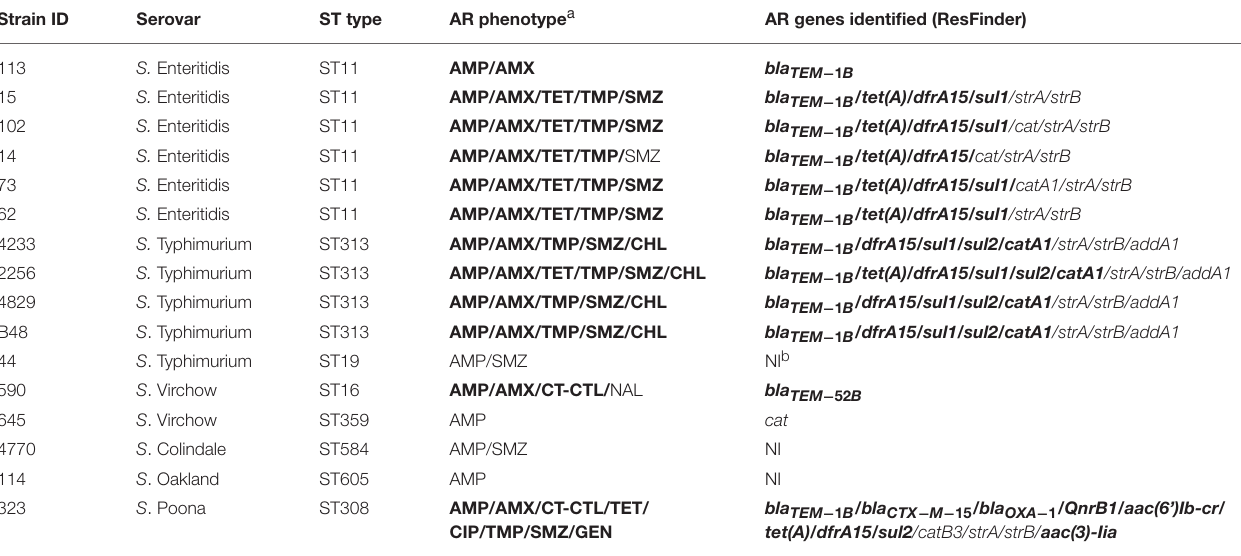
TABLE 1 | Salmonella enterica isolates included in the study and their relevant characteristics. Strain